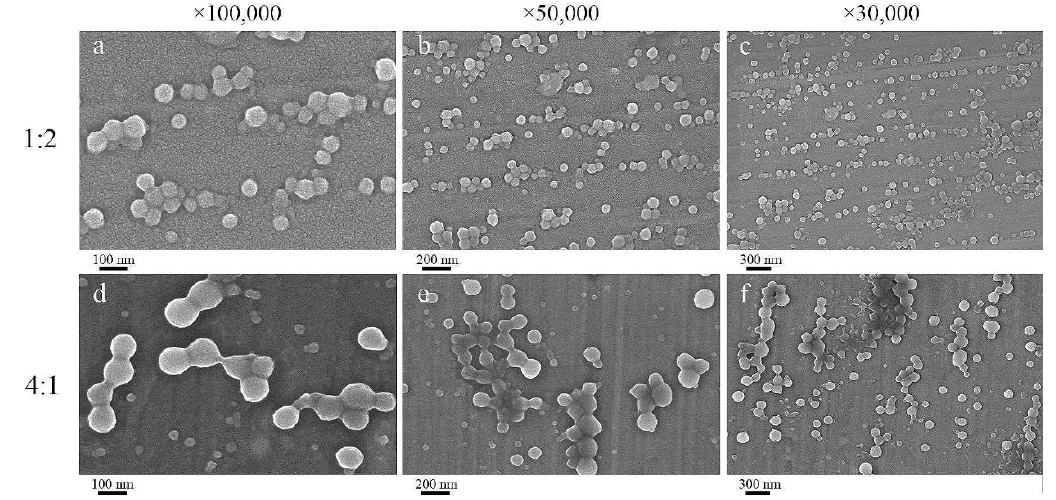
Figure 6. FE-SEM images of CA-loaded composite NPs: m (zein)/m (SC) = 1:2 (( a ) 100 nm; ( b ) 200 nm; ( c ) 300 nm); m (zein)/m (SC) = 4:1 (( d )100 nm; ( e ) 200 nm; ( f ) 300 nm).